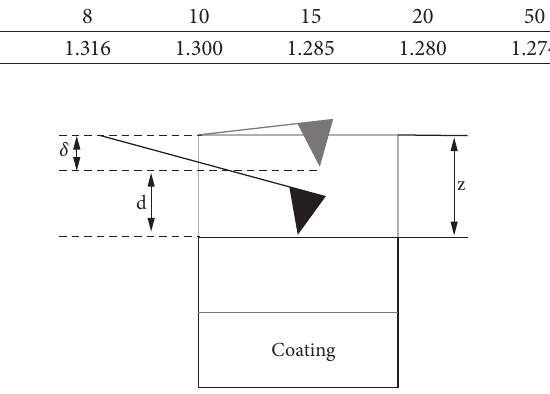
Figure 3: Relative movements of the sample-AFM tip system in the indentation experiment.